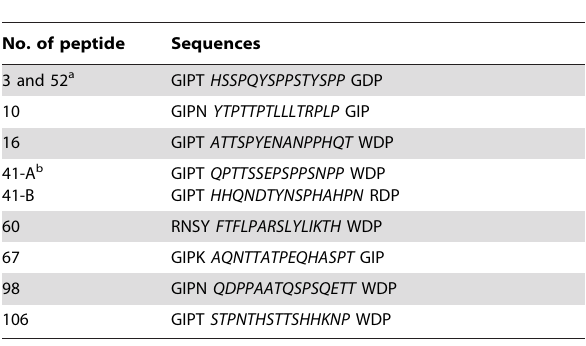
Table 1. Nonphosphorylated peptides interacting with the Grb7 SH2 domain (abridged sequences of conserved amino acid